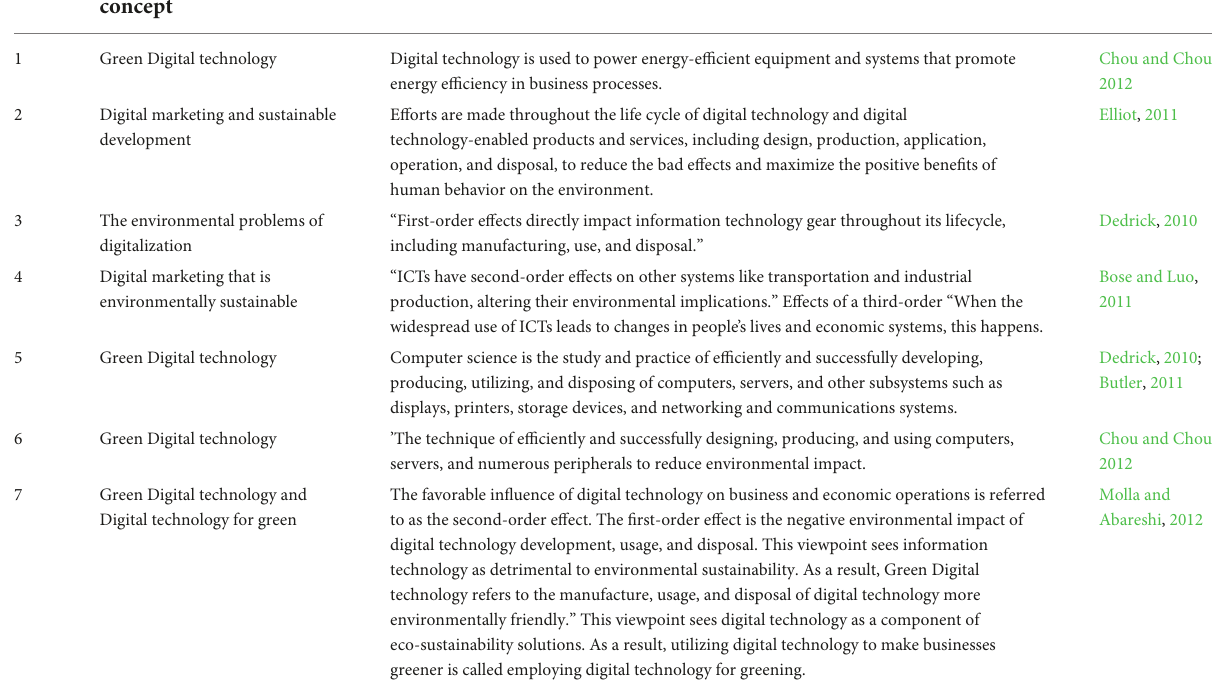
TABLE 2 Overview of the role of digital technology and its